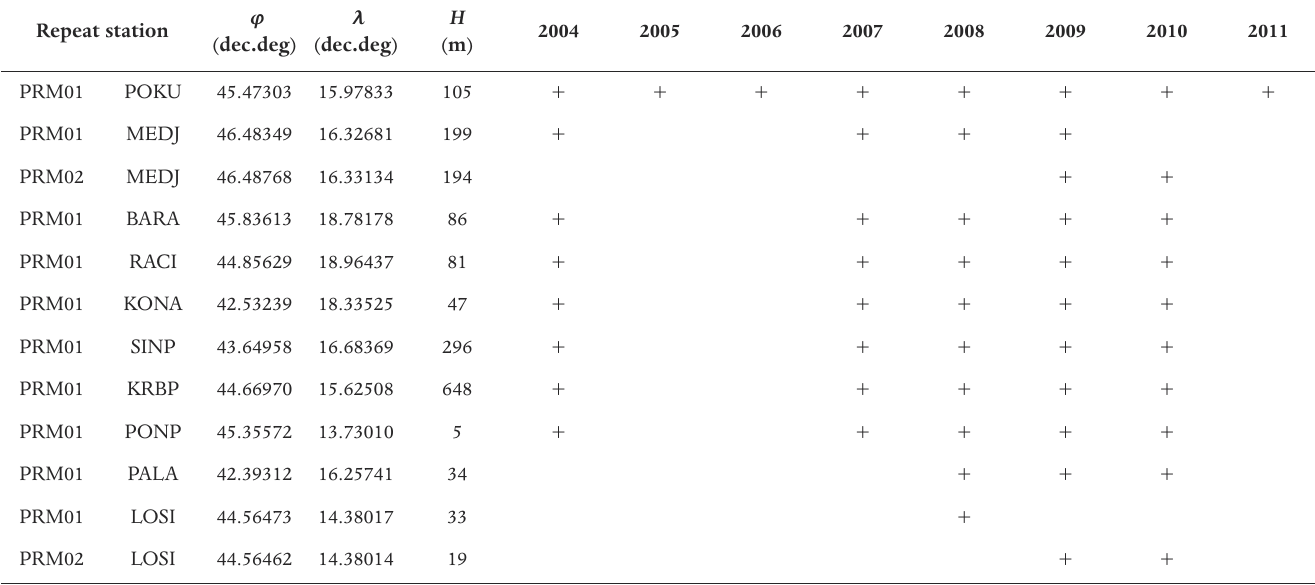
Table 1. The primary repeat stations and years of surveys. The latitude and longitude were given in ETRS89, and H was orthometric